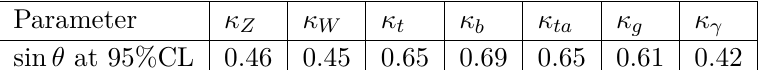
Table 4 . Upper limit on sin θ obtained from Higgs boson coupling modifiers, κ 95% CL